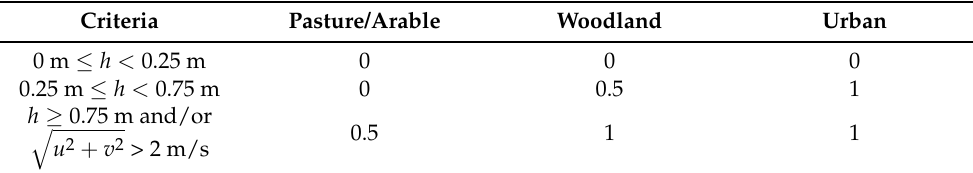
Table 3. Debris factor values.